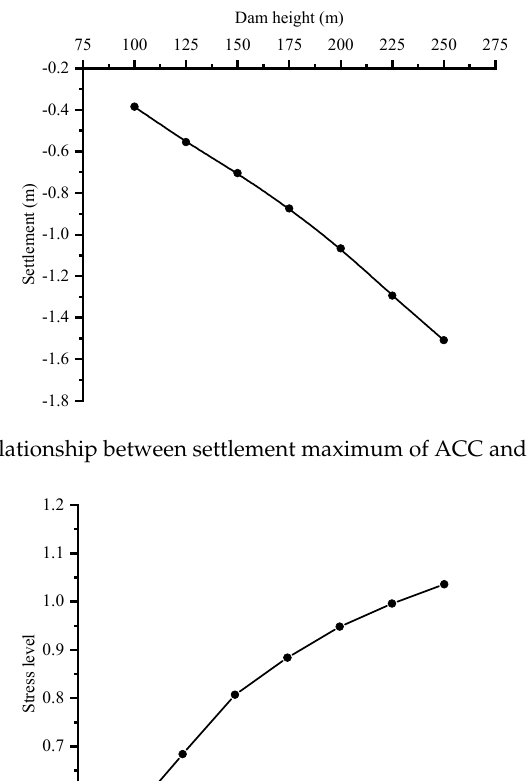
Figure 7. Stress level contours of ACC ( h =200 m) .